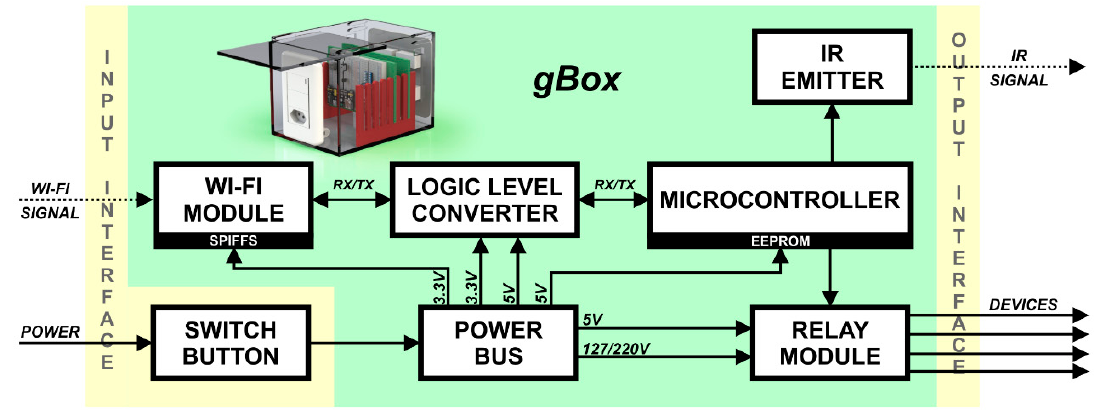
Figure 4. GlobalBox (gBox) of the assistive system.